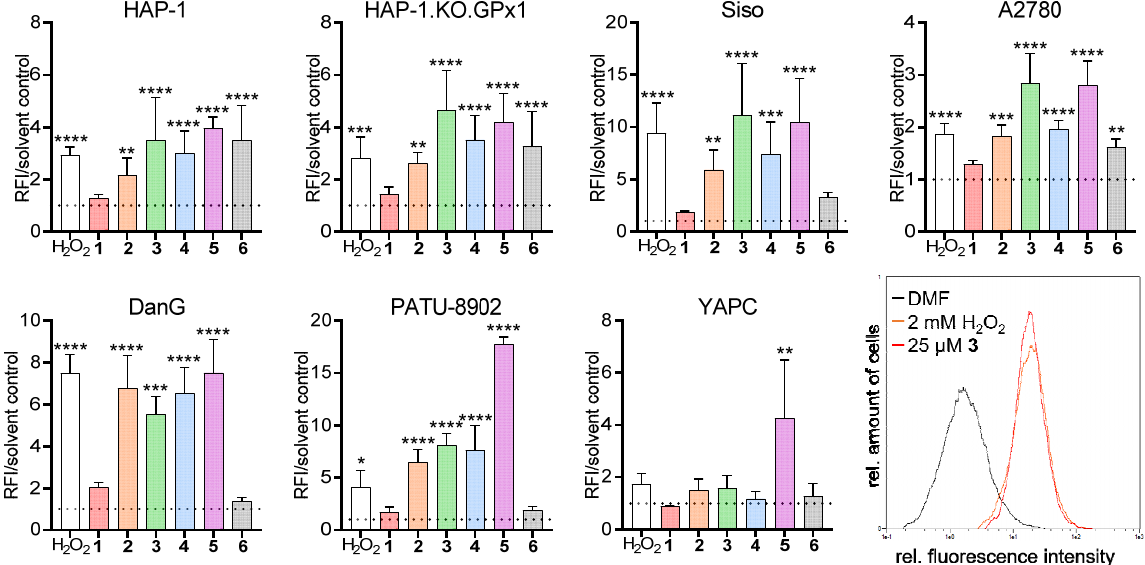
Figure 8. Relative intracellular levels of ROS after incubation for 15 min with 25 µM of pentathiepin 1 – 6 detected via flow cytometric DCFDA-based assay in seven cancer cell lines. Solvent only was used as the negative control, 2.0 mM of H 2 O 2 was used as the positive control. Data are displayed as mean and SD, and a representative histogram from flow cytometric analysis is included (bottom right). All treatment conditions were related to the negative control sample (set to 1, dashed line) and statistical analysis performed in Prism 7 by one-way ANOVA and Dunnett’s multiple comparisons post hoc test. n ≥ 3 independent experiments, * p < 0.05, ** p < 0.01, *** p < 0.001, **** p < 0.0001.